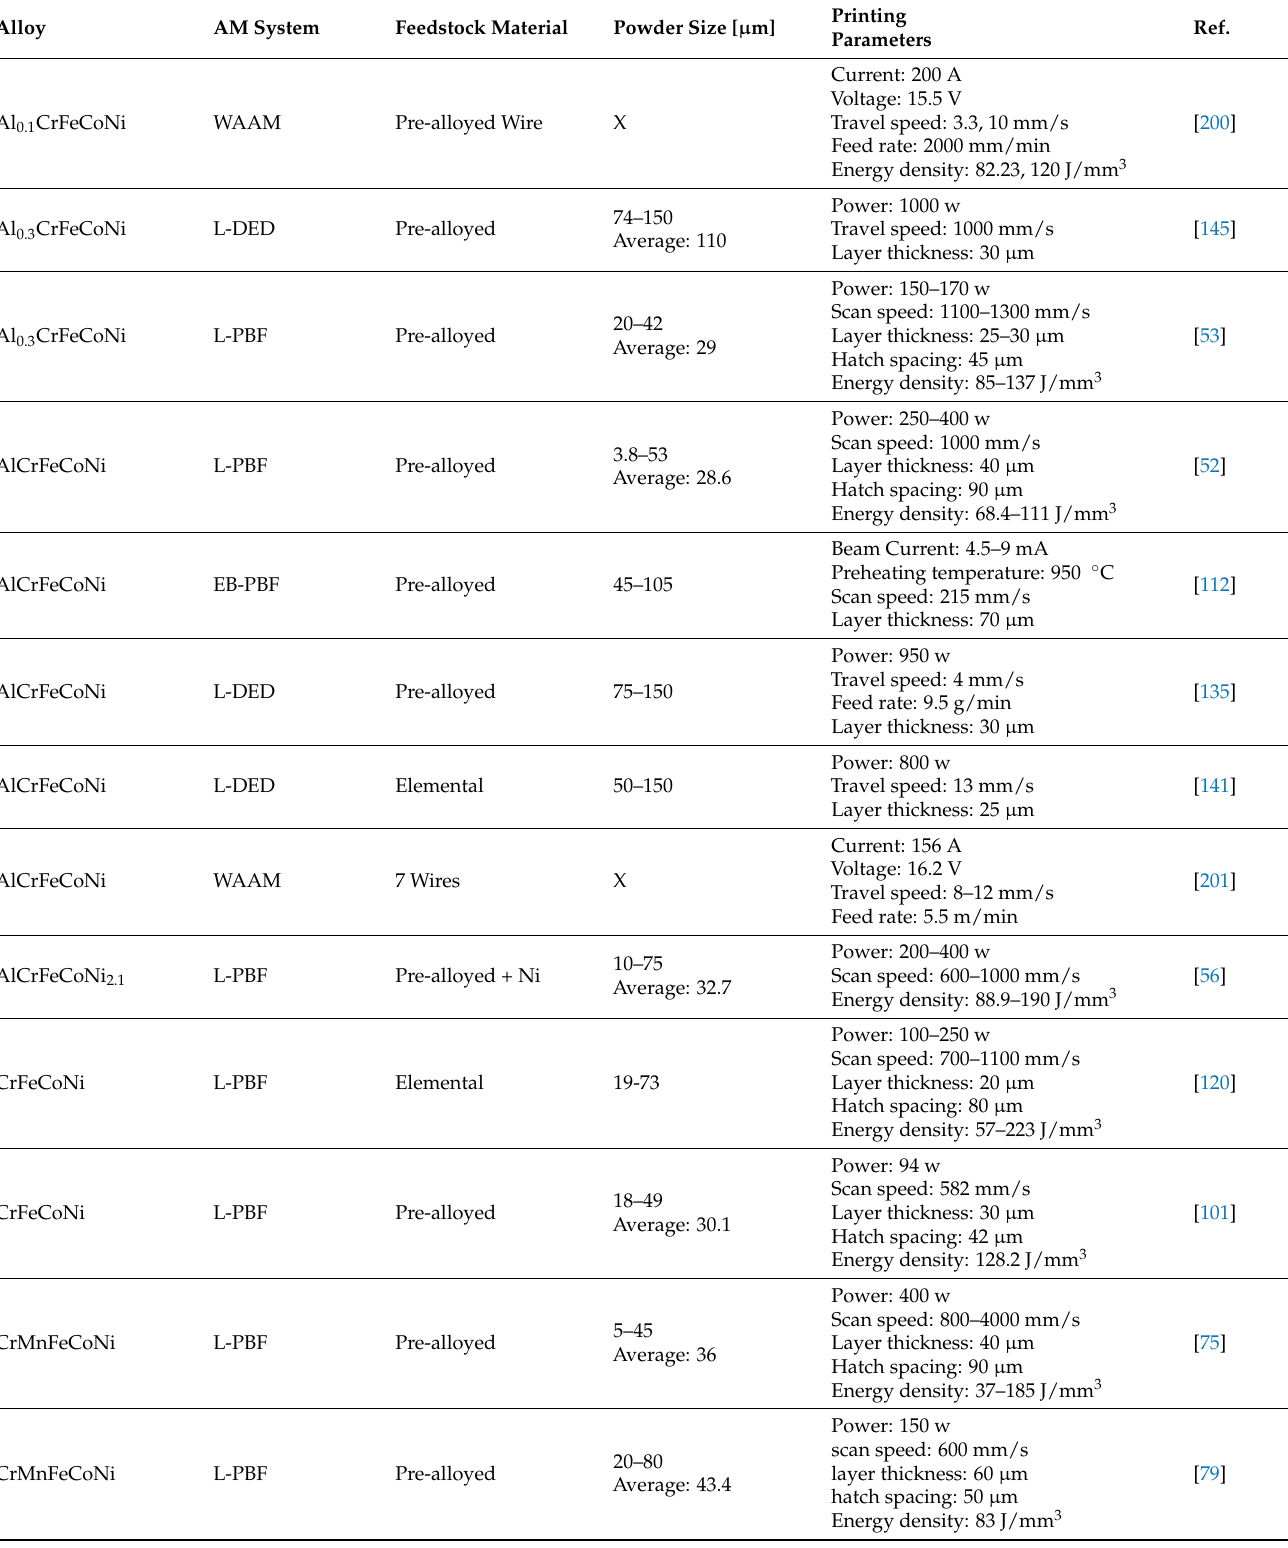
Table 11. Printing parameter of selected HEA compositions produced by different AM